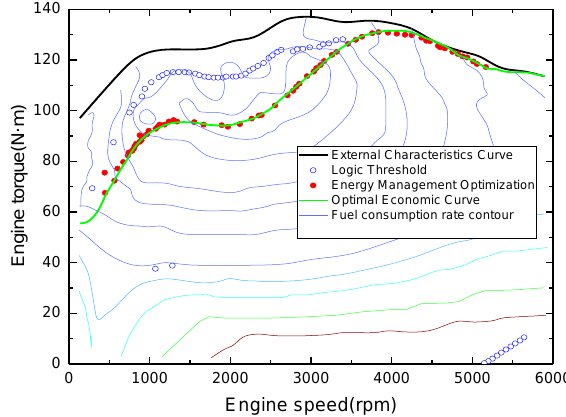
Sensors 2021 , 21 , x FOR PEER REVIEW Figure 18. Engine operating point. Figure 18. Engine operating point.